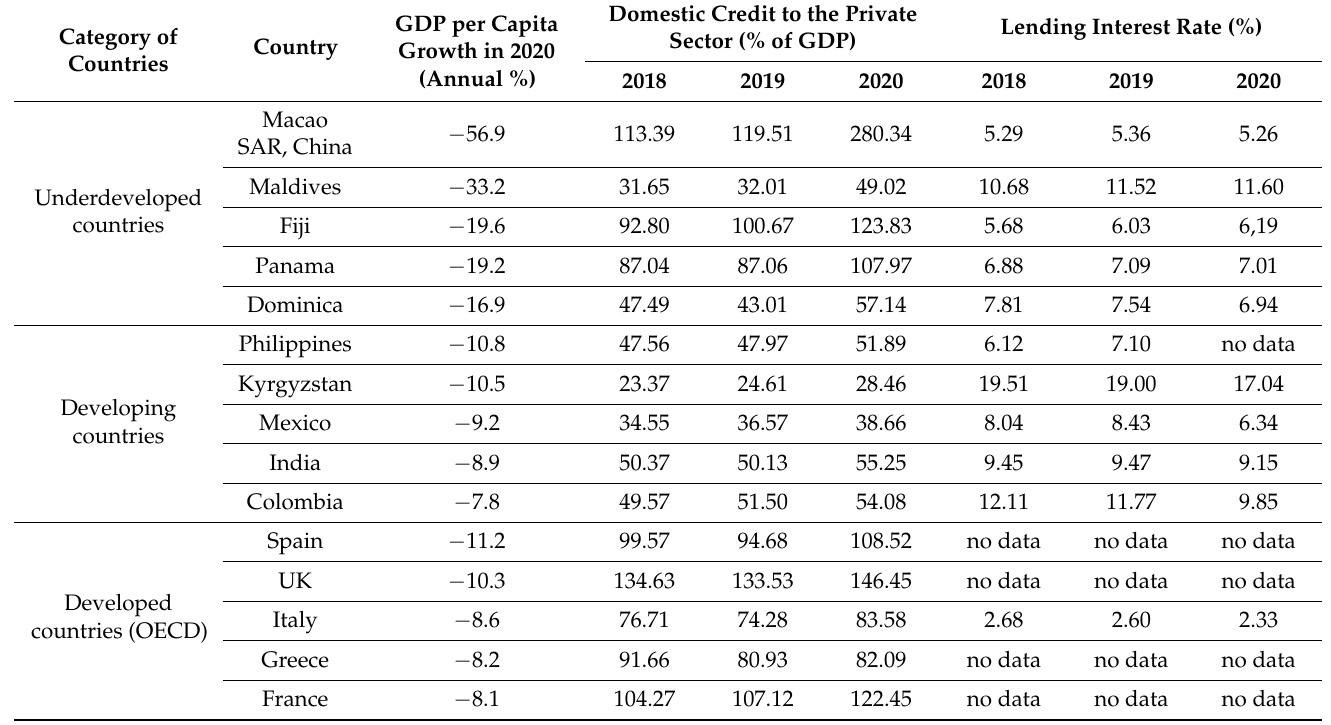
Table 1. Statistics characterizing credit risks in the highlighted categories of countries in 2018–2022.